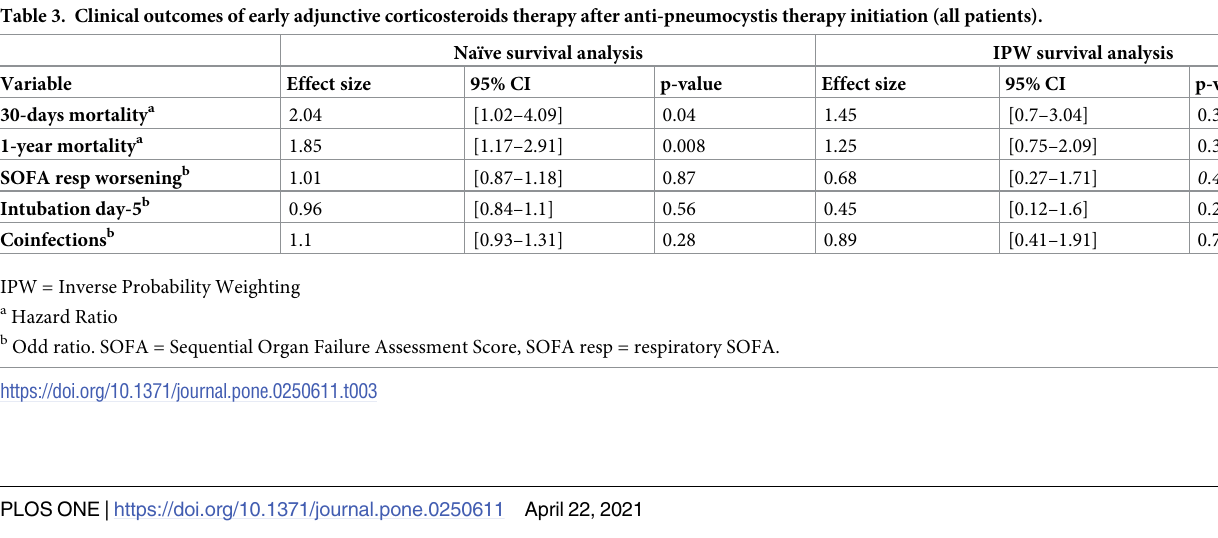
Table 3. Clinical outcomes of early adjunctive corticosteroids therapy after anti-pneumocystis therapy initiation (all patients). Na ï ve survival analysis